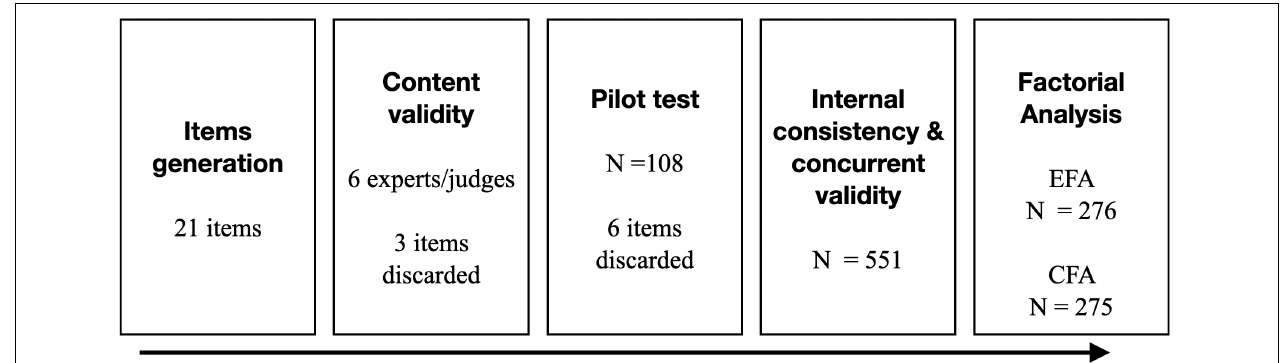
FIGURE 1 | Steps from item generation to analysis to factor